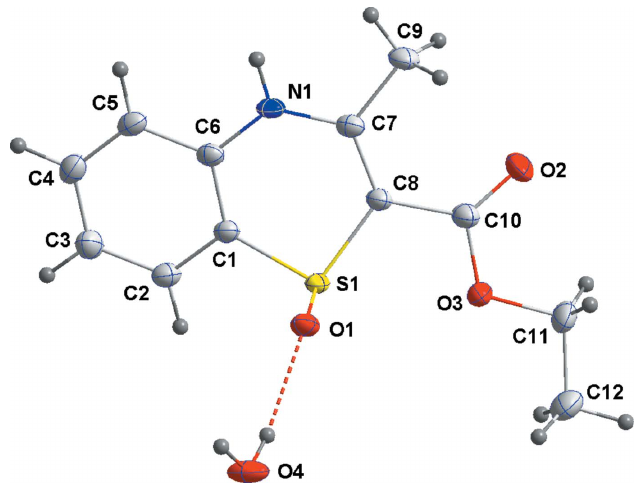
Figure 1 The title molecule with labeling scheme and 50% probability